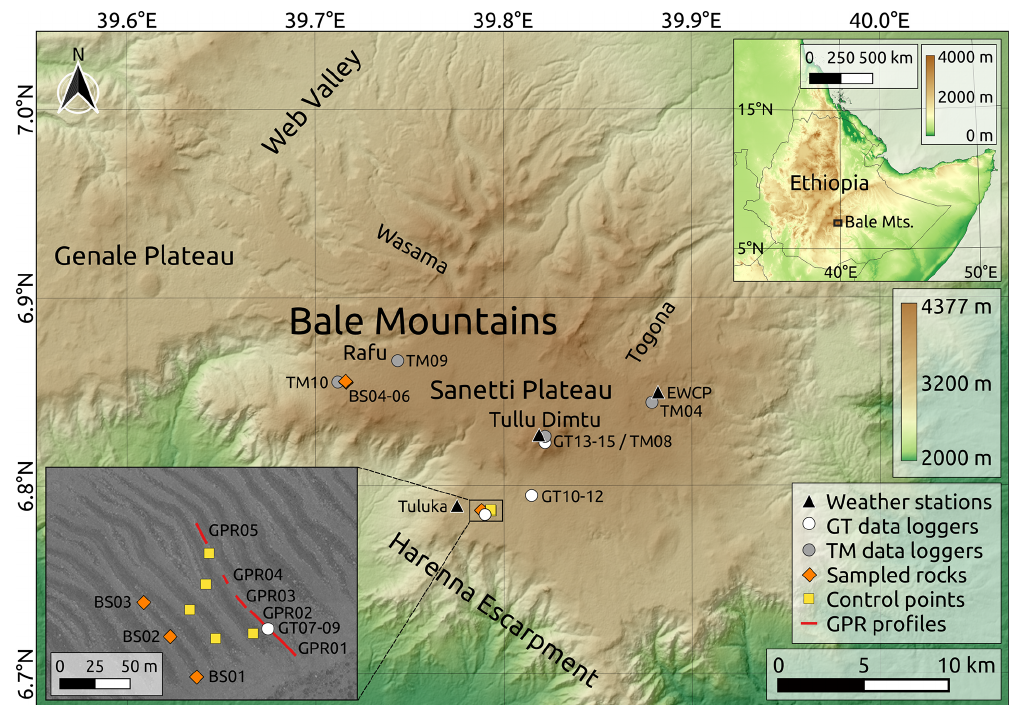
Figure 1. Overview map of the experimental setup and observational network in the Bale Mountains (southern Ethiopian Highlands) located in the Horn of Africa. The automatic weather stations as well as the high-quality (GT) and low-cost (TM) ground temperature data loggers on the Sanetti Plateau were installed from January to February 2017. Unmanned aerial vehicle and ground-penetrating radar surveys were performed to obtain information on the morphology and internal structure of the stone stripes (see GPR profiles in the lower left map inset). Six rocks from two different stone stripes were sampled for surface exposure dating. Data basis: SRTM 1 Arc-Second Global (United States Geological Survey) for the main map and upper right inlet; high-resolution WorldView-1 satellite image (DigitalGlobe Foundation) for the lower left inlet. Ground control points (i.e. natural objects; yellow squares in the inlet) visible on the georectified WorldView-1 image and on the UAV images served for georeferencing the UAV